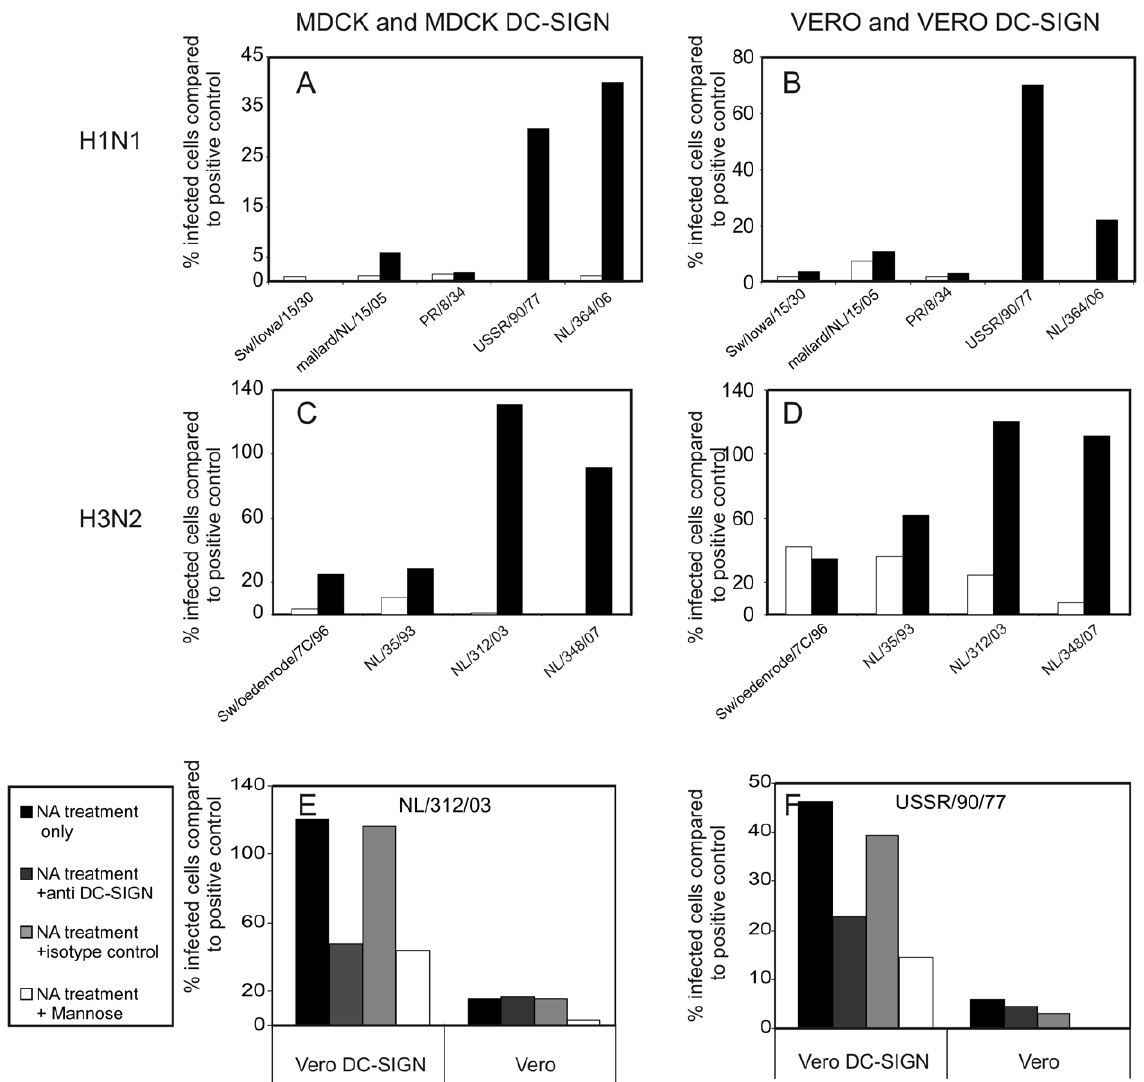
Figure 5. Expression of DC-SIGN supports replication of influenza A viruses in the absence of sialic acids. MDCK (A and C) and Vero cells (B and D) transfected with the DC-SIGN gene (black bars) or not (white bars), were treated with neuraminidase from vibrio cholerae and GolgiStop for 30 minutes to remove sialic acids from the cell surface. These cells were subsequently inoculated with five different A/H1N1 viruses (A and B) and four A/H3N2 viruses (C and D). The percentage infected cells relative to the untreated control cells, still possessing sialic acid, was assessed after detecting infected cells using a FITC-labelled antibody to the viral nucleoprotein and flow-cytometry. To confirm that the entry was mediated via DC-SIGN, Vero and Vero DC-SIGN were treated with neuraminidase from vibrio cholerae for 30 minutes to remove sialic acids from the cell surface and incubated with or without antibodies to DC-SIGN or an isotype control antibody as indicated (E and F). These cells were subsequently inoculated with influenza viruses. NL/312/03 and USSR/90/77. The percentage of infected cells compared to the positive control (untreated cells, still possessing sialic acid) was assessed as described above.